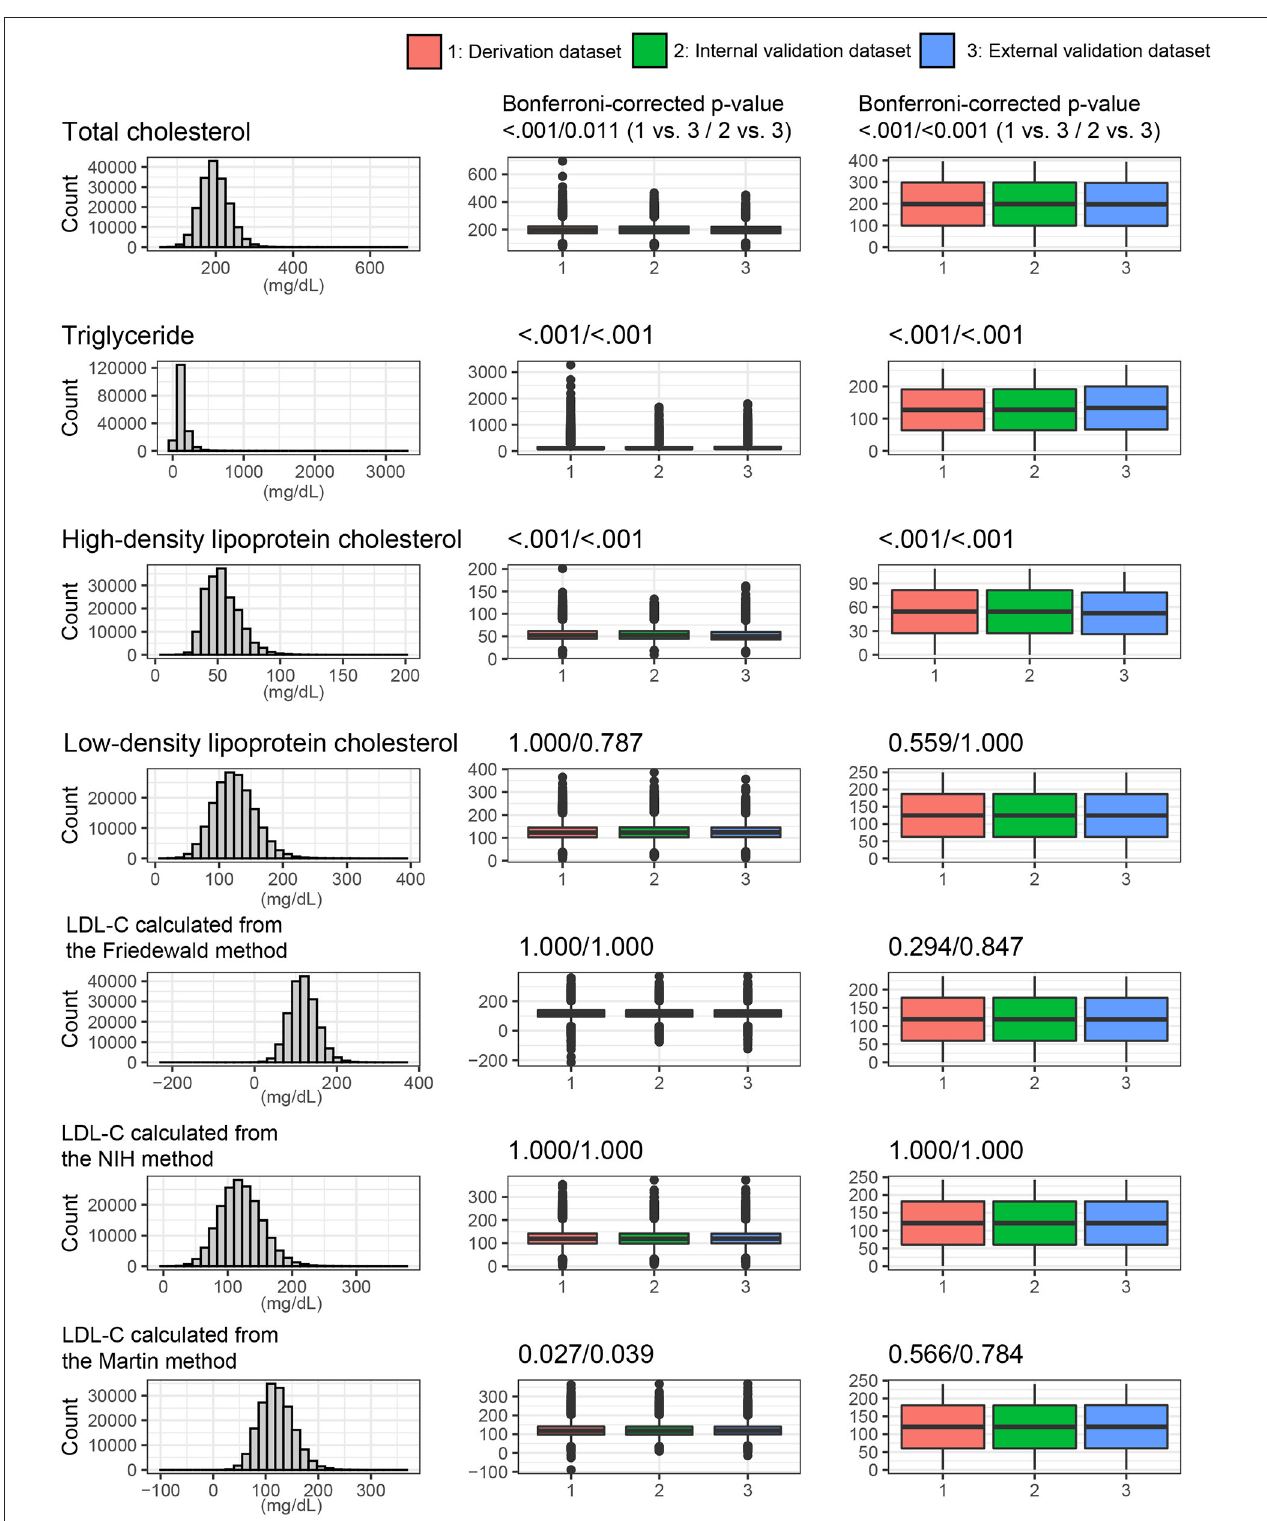
FIGURE 4 | Lipids profiles and LDL values from the various LDL equations. The distribution of whole dataset was described. P values were calculated using the t -test and Mann-Whitney U test for continuous variables.